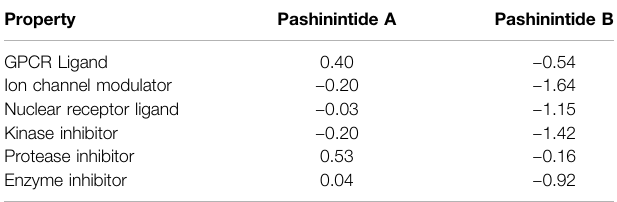
TABLE 3 | Bioactivity scores for the Pashinintides A and